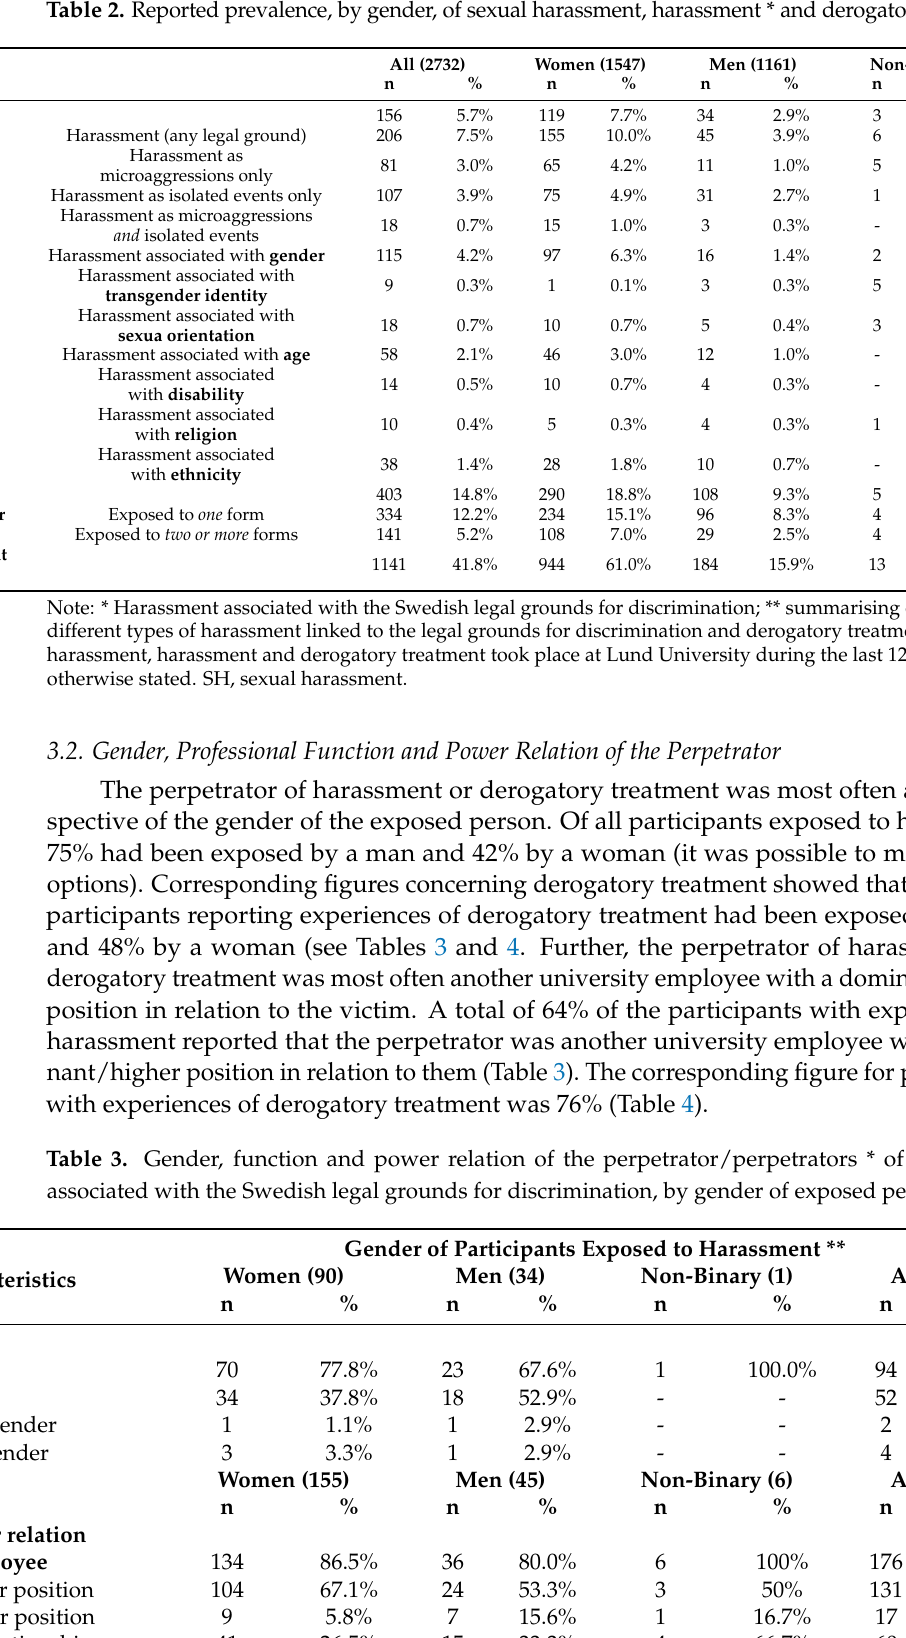
Table 2. Reported prevalence, by gender, of sexual harassment, harassment * and derogatory treatment.